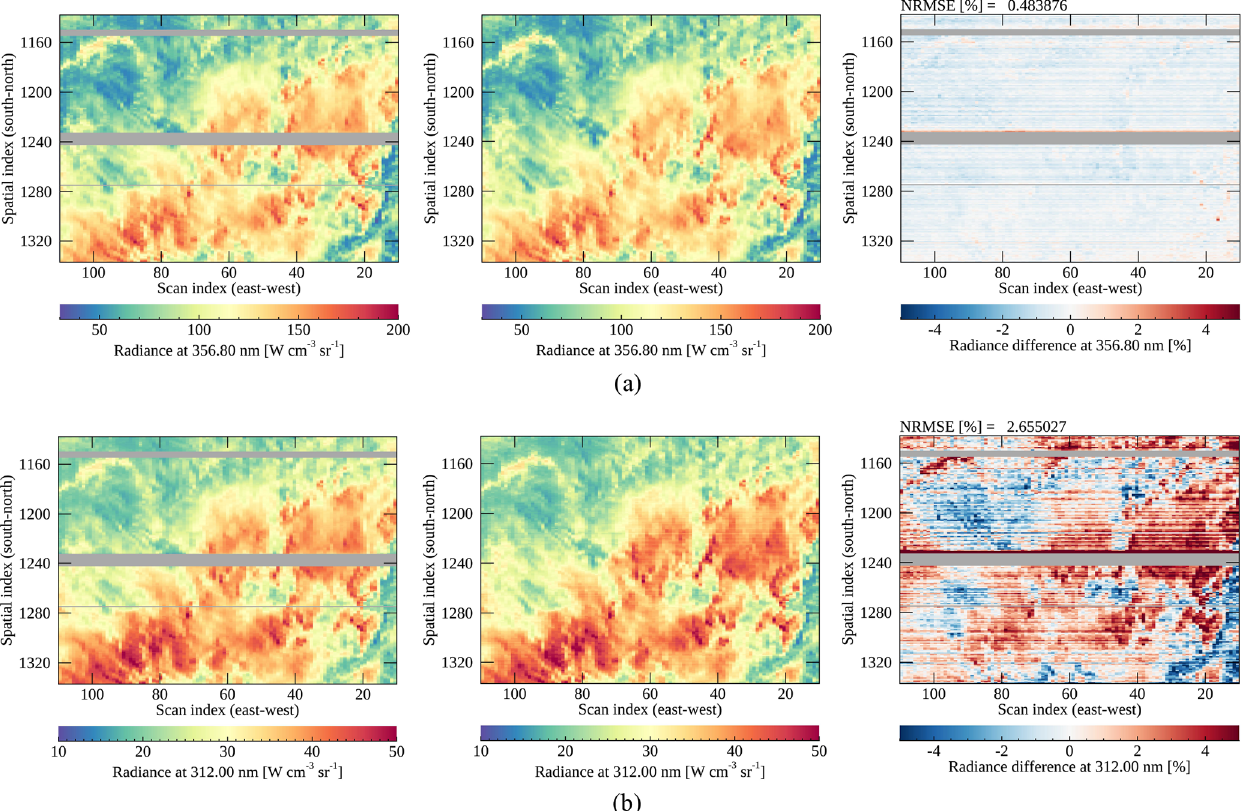
Figure 9. Same as Fig. 8 for the Defect 2 area with the color bar range for differences within ±